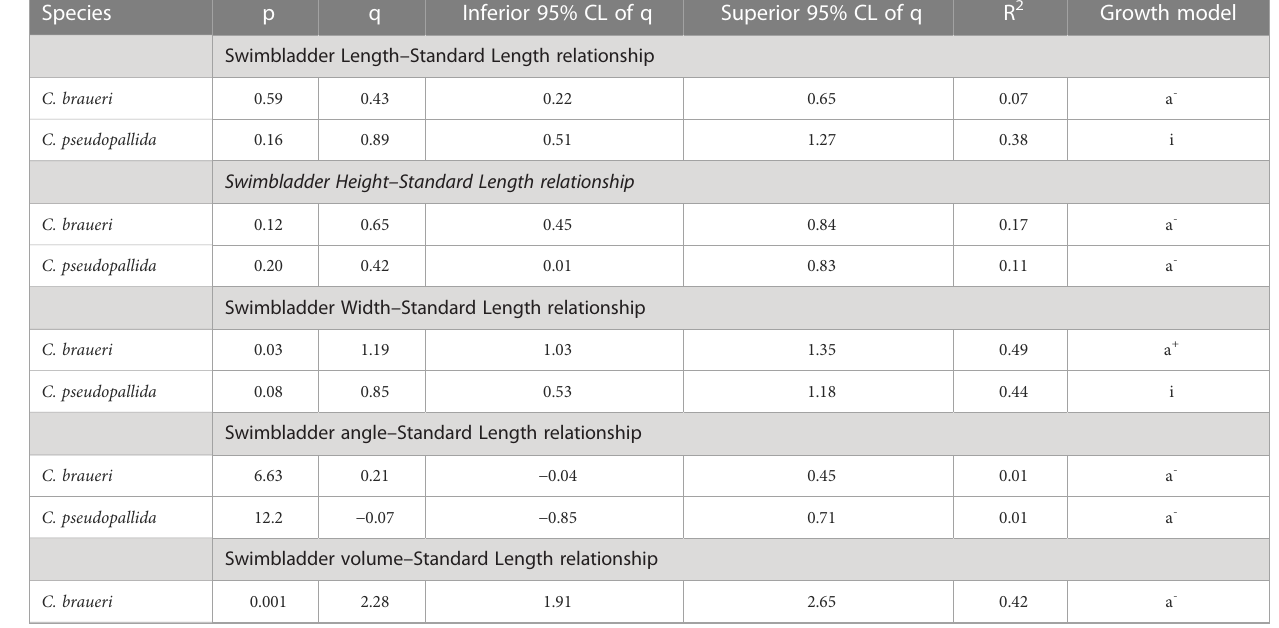
TABLE 6 Parameters of regressions of swimbladder measurements (Sw i , mm) and standard length (SL, mm) for semi-transparent Cyclothone species in Atlantic waters Sw i = p ∗ SL q CL (con fi dence interval).